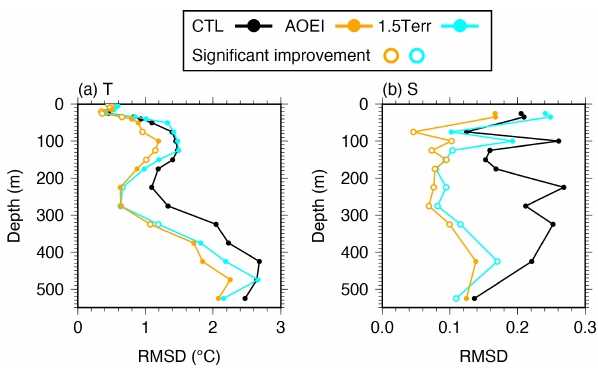
Figure 12. (a) Temperature and (b) salinity RMSDs averaged over the whole experimental period at the KEO buoy in the CTL (black), AOEI (orange), and 1.5Terr (cyan) runs. Open circles indicate sig- nificant improvement in the AOEI and 1.5Terr runs relative to the CTL run.